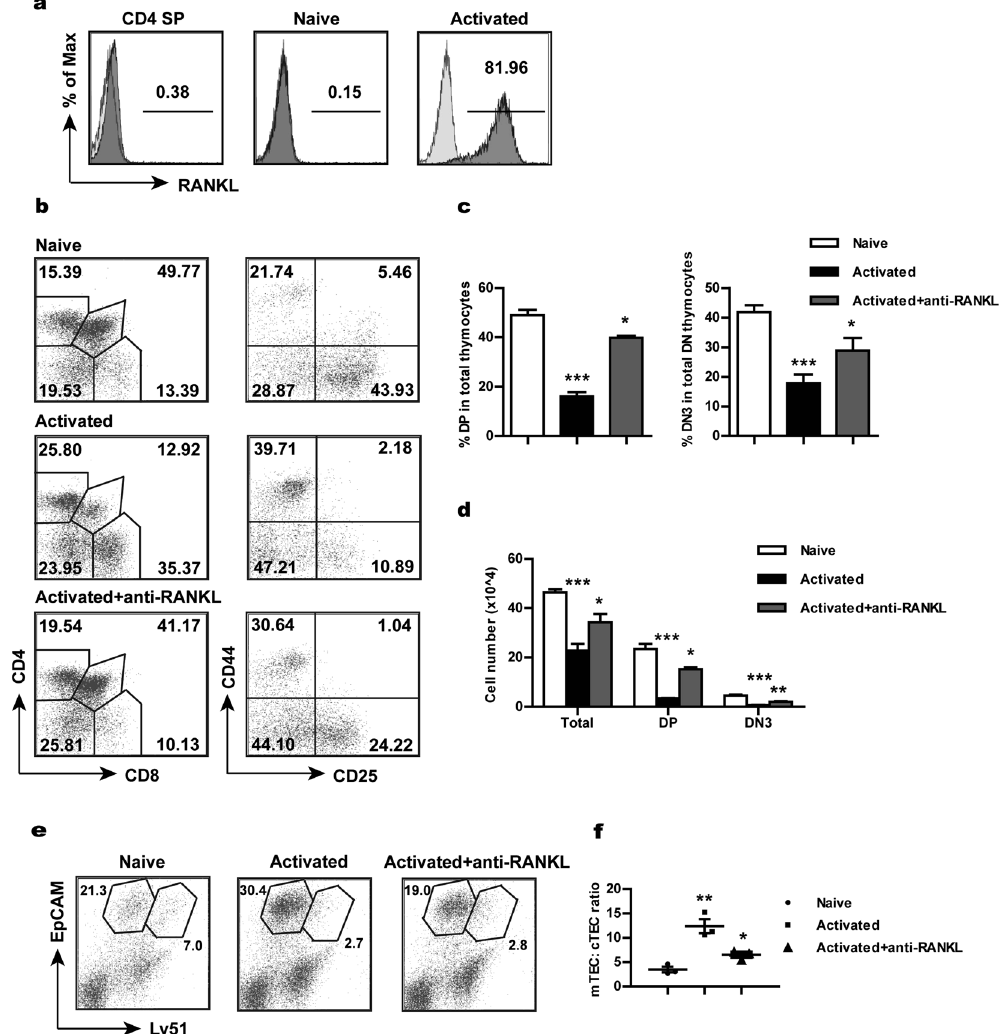
Figure 5. Implication of RANK signaling in activated CD4 + T cell-induced effects. ( a ) The expression level of RANKL measured by flow cytometry in CD4 SP thymocytes, naive CD4 + T cells and anti-CD3/CD28-activated CD4 + T cells. Shallow shades represent the staining controls. ( b ) Fetal thymuses were co-cultured with activated T cells with or without the addition of neutralising antibodies against RANKL and analysed at day 12. Dot plots show representative profiles for CD4/CD8 staining (gated on CD45.2 + cells) of total thymocytes and for CD25/ CD44 staining (gated on CD45.2 + CD4 − CD8 − DN cells) of DN cells. The number indicates the percentage of cells within the gate. ( c , d ) The percentage of DP and DN3 cells ( c ) and the absolute number of total, DP and DN3 thymocytes ( d ) in FTOCs under different conditions. ( e , f ) Flow cytrometric analysis of EpCam and Ly51 expression by MACS-enriched CD45 − thymic stromal cells (gated on CD45 − cells). Representative dot plots ( e ) and the ratio of mTECs versus cTECs ( f ) are shown. The experiments were repeated three times. Each experiment included 20–30 fetal thymic lobes for each group, which were then pooled for analysis. Each dot represents the result from a single experiment. Data are presented as Mean ± SEM. * p < 0.05, ** p < 0.01; *** p <